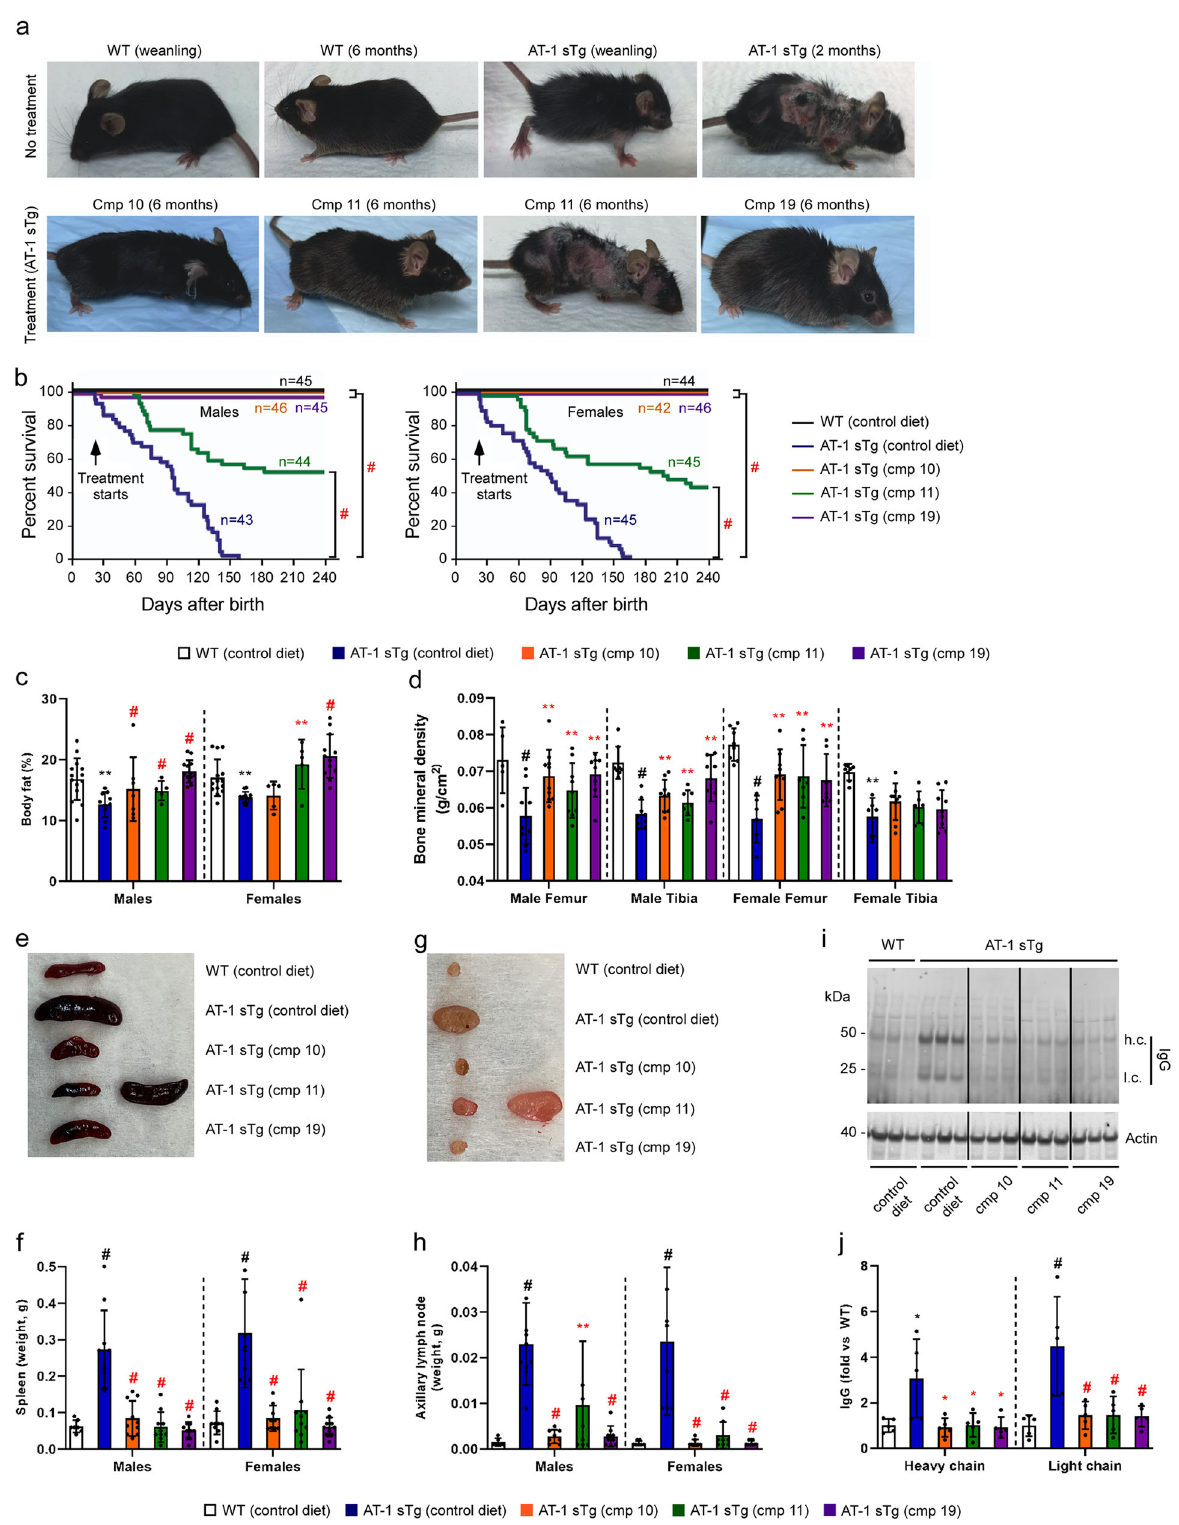
Fig. 4 ATase inhibitors rescue the AT-1 sTg phenotype. a Representative images of WT and AT-1 sTg mice with and without treatment. b Lifespan of WT mice on control diet and AT-1 sTg mice on either control or Compound 10, 11, or 19 diets. Treatment started at weaning. c Quanti fi cation of body fat. d Quanti fi cation of bone mineral density. e Representative image of spleens. f Quanti fi cation of ( e ). g Representative image of axillary lymph nodes. h Quanti fi cation of ( g ). i Representative Western blot showing IgG heavy chain (h.c.) and light chain (l.c.) levels in liver. j Quanti fi cation of ( i ). For c – j mice were studied at approximately 3 months of age. Bars represent mean ± SD . * p < 0.05, ** p < 0.005, *** p < 0.0005, # p < 0.0001 via ordinary two-way ANOVA with Tukey ’ s multiple comparison test. Black symbol, signi fi cance vs WT; Red symbol, signi fi cance vs untreated/control diet AT-1